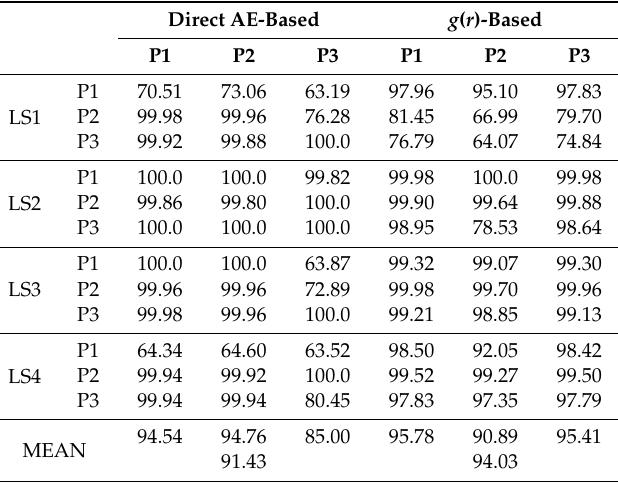
Table 9. Accuracy (%) of classifiers trained with leak